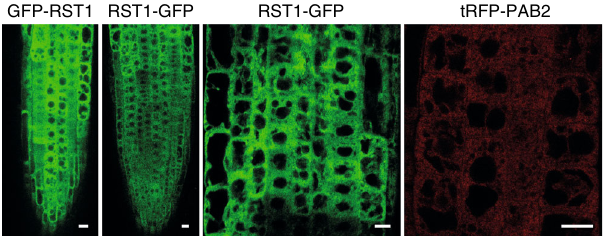
Fig. 3 RST1 is a cytosolic protein. Confocal microscopy of root tips from Arabidopsis rst1-3 plants expressing GFP-RST1 and RST1-GFP fusion proteins under the control of the constitutive UBIQUITIN 10 promoter. Poly(A)- binding protein 2 at its N-terminus fused to tRFP (tRFP-PAB2) and expressed under the control of its own promoter is shown as cytosolic marker. Scale bars are 10 µ m. The source data are available at [https://doi. org/10.6084/m9. fi gshare.c.4483406]